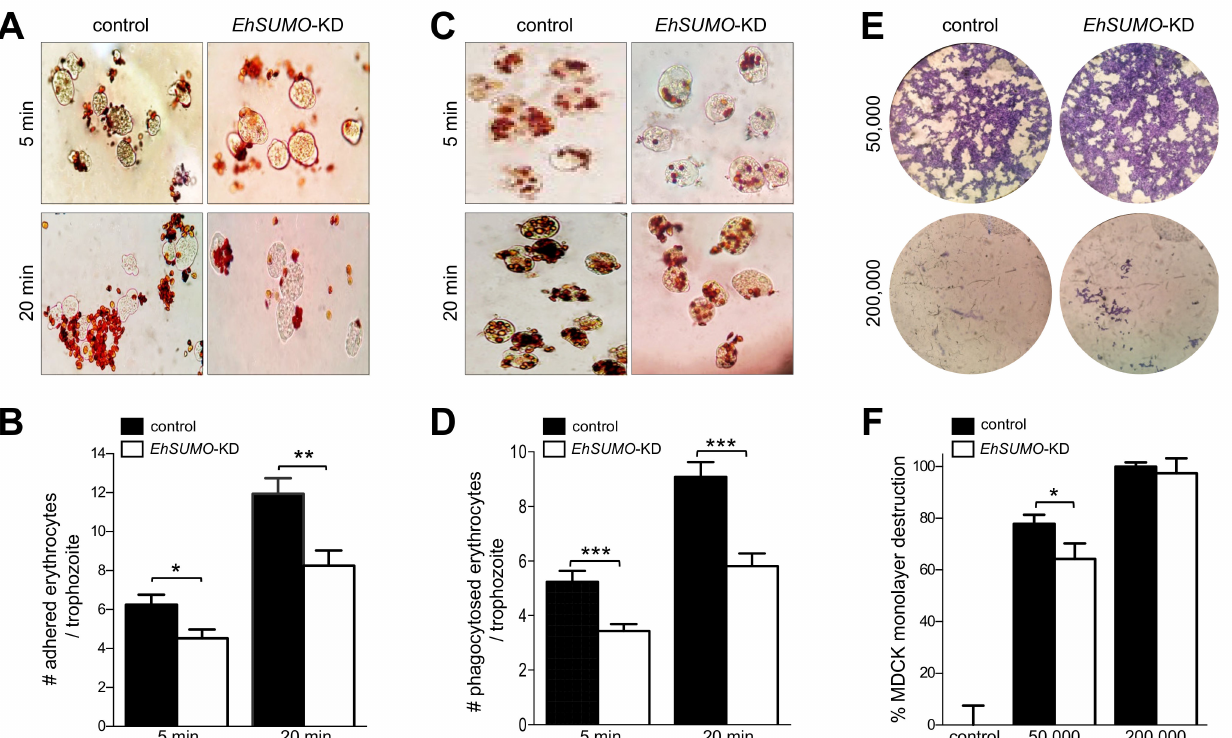
Figure 11. Effect of EhSUMO knock-down in the adhesion, phagocytosis, and cytopathic effect. ( A ) Novikoff staining of control and EhSUMO -KD trophozoites at 5 and 20 min of adhesion to erythrocytes. ( B ) Number of adhered erythrocytes per trophozoite. ( C ) Novikoff staining of control and EhSUMO-KD trophozoites at 5 and 20 min erythrophagocytosis. ( D ) The rate of erythrophagocytosis was evaluated by counting the number of erythrocytes per trophozoite. Data represent the median and standard error of 100 trophozoites ( E ) The MDCK monolayer damage produced by different amounts (50,000 and 200,000) of control and KD-trophozoites was evidenced by methylene blue staining. ( F ) The destruction of epithelial cells was calculated by measuring the remaining dye concentration in the cell monolayer after contact with trophozoites. Control: MDCK cells non-incubated with trophozoites. Values represent the median and standard error of the three independent experiments. (*) p < 0.05, (**) p < 0.01, (***) p <